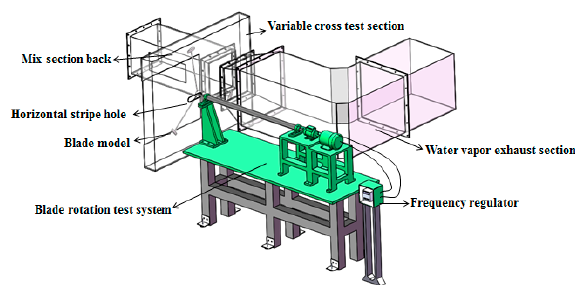
Figure 3. 3D diagram of rotation system.